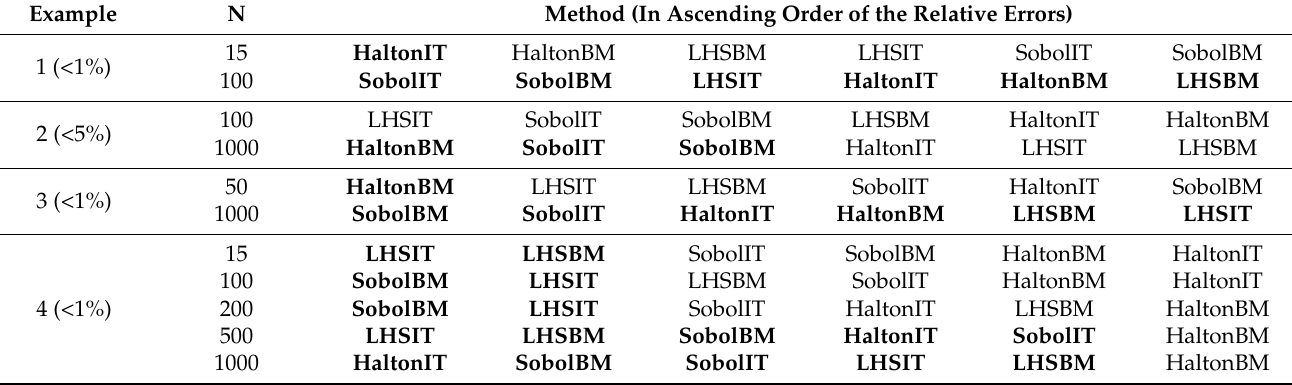
Table 9. Rank of the methods according to the relative errors of failure probability sensitivity. Method (In Ascending Order of the Relative